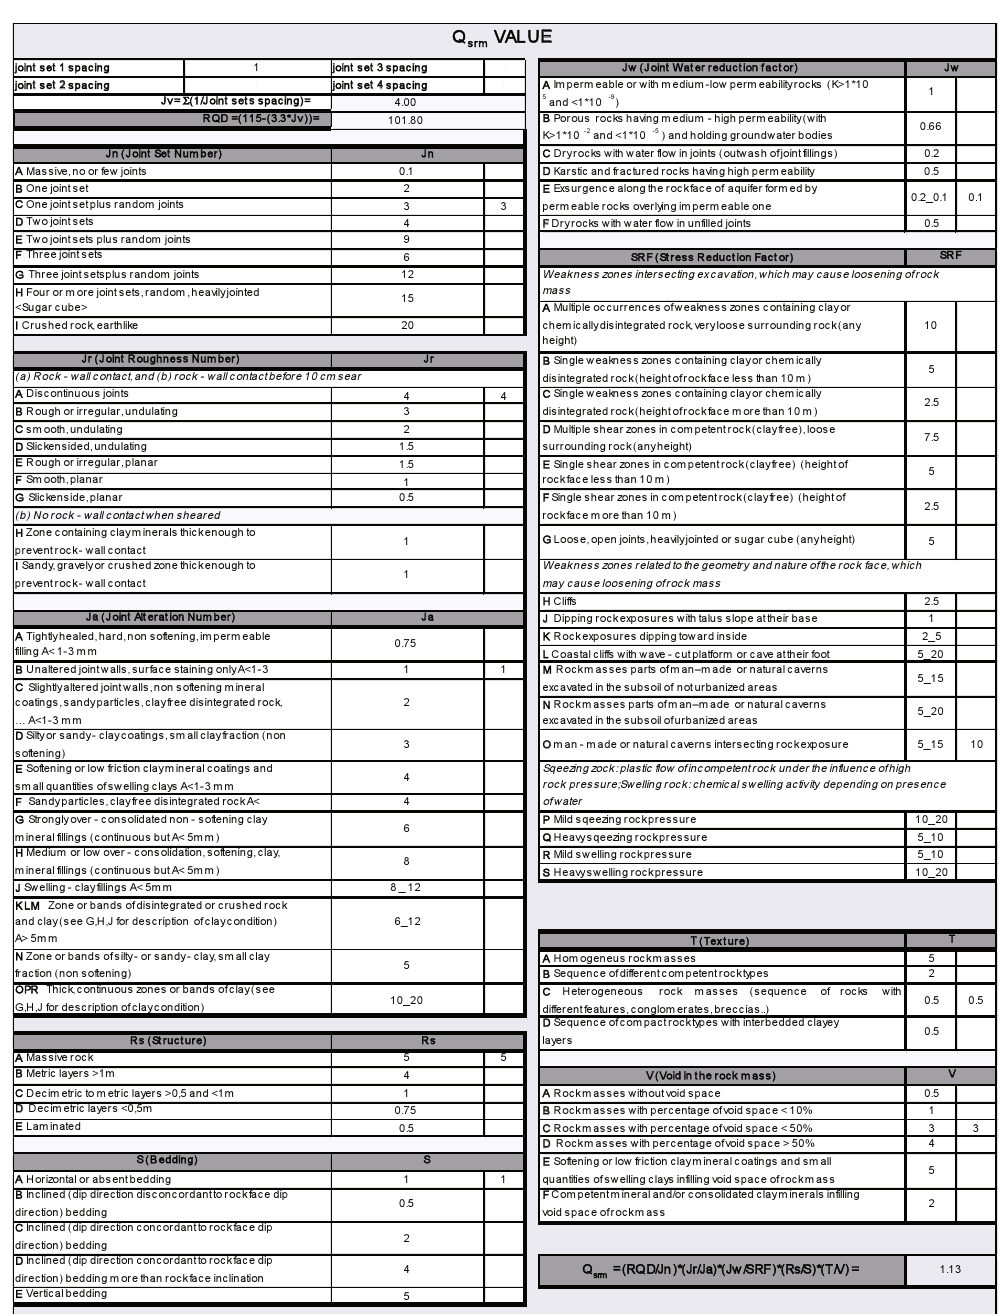
Fig. 7. Rock mass quality of Otranto rock